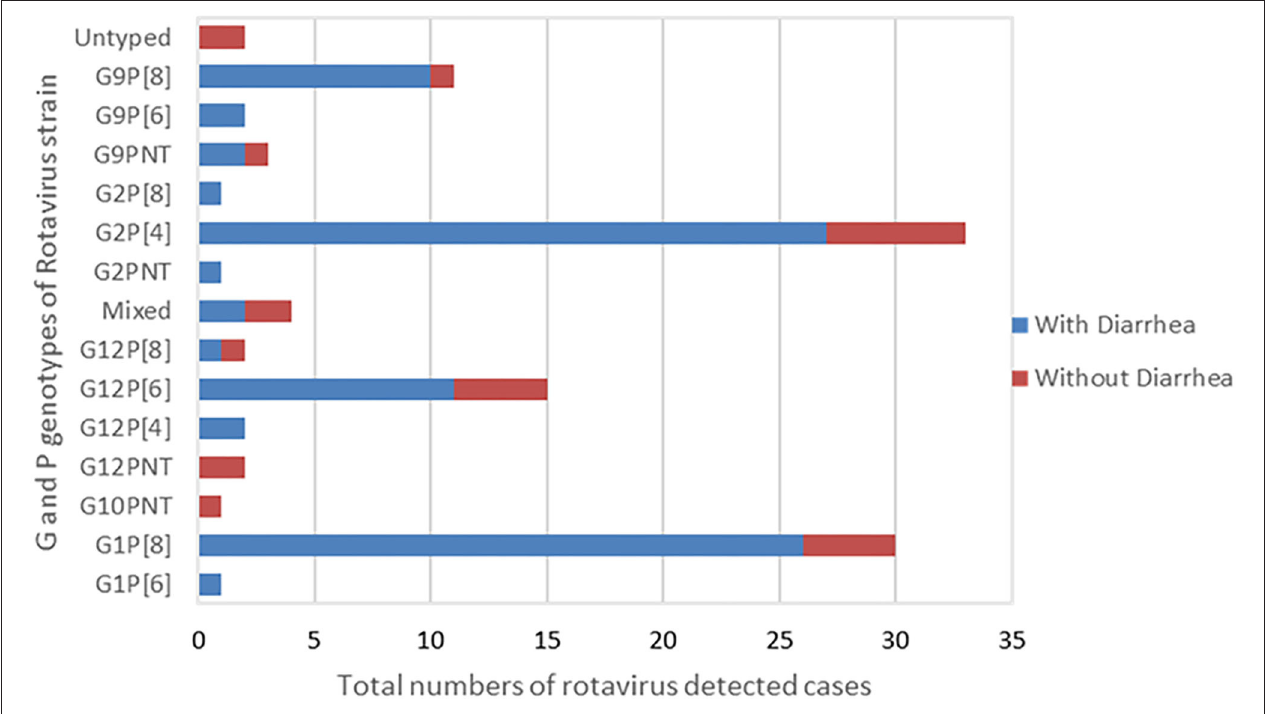
FIGURE 2 | G and P Genotype combination of the rotavirus strains typed by RT-PCR. The graph presents total numbers of rotavirus strain of G and P genotype combination detected in children with presentation of diarrhea and without diarrhea.